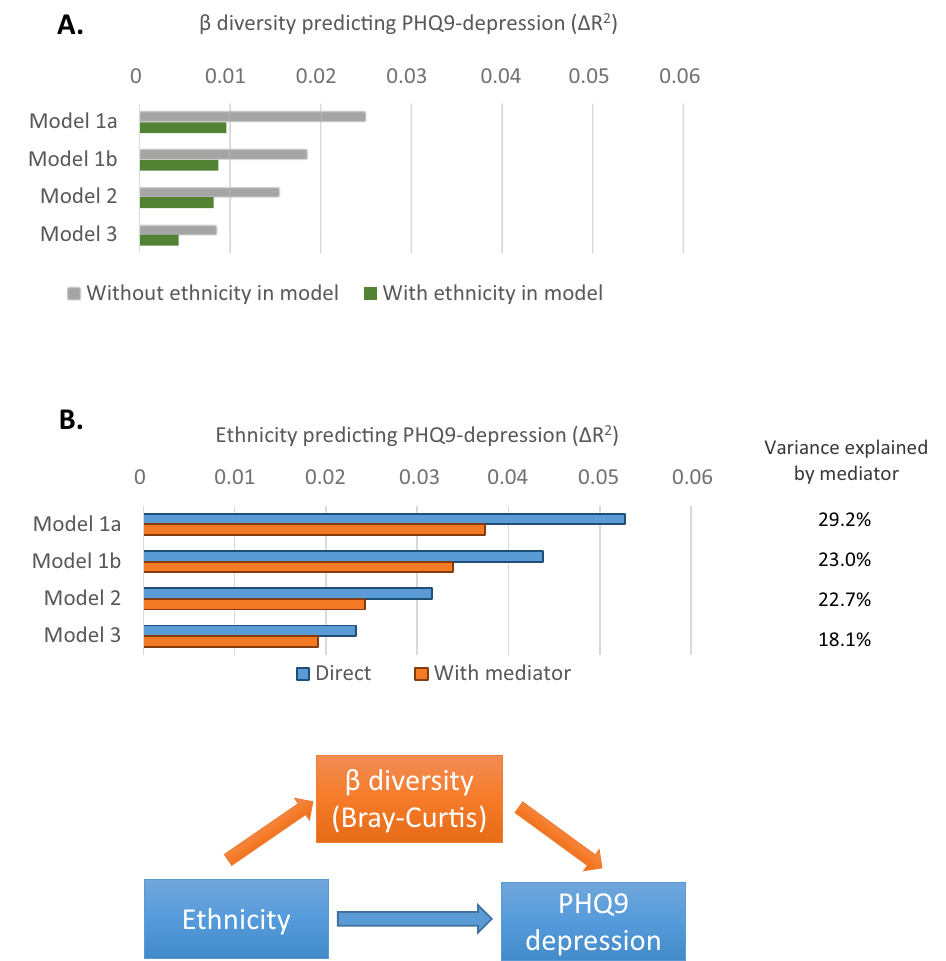
Fig. 1 | Beta-diversity is linked with ethnic differences in depressive symptom scores. A Beta-diversity predicting PHQ9 depression. It presents results of linear regression analyses that model β -diversity as a predictor of depressive symptom levels. Panel ( A ) horizontal bars present Δ R 2 after progressive adjustments for confounders(models1ato3),andrespectivelywithoutandwithethnicityincluded in each regression model. B Ethnicity predicting PHQ9 depression. It presents results of linear regression in which β -diversity is modeled as a mediator of the association between ethnicity and depressive symptom levels (see lower fi gure). Barspresent Δ R 2 thepredictionofPHQ9byethnicityafterprogressiveadjustments